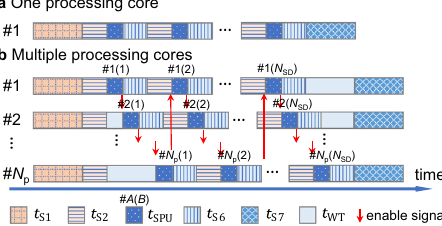
Fig. 6 Schematic fi gure of calculation time based on pipeline design when one processing core a or multiple processing cores b are used in MPU. The t S1 , t S2 , t S3 , t S4 , t S5 , t S6 , and t S7 are the calculation time of S1, S2, S3, S4, S5, S6, and S7, respectively, in Fig. 5. Here, t SPU = t S3 + t S4 + t S5 ; and t WT is the waiting time; ‘ # A ( B ) ’ stands for the sub-domain B processed by the core # A of MPU; N p is the number of cores in MPU; N SD is the number of sub-domains decomposed according to the SPU capacity. Enable signals are used to coordinate the calling of